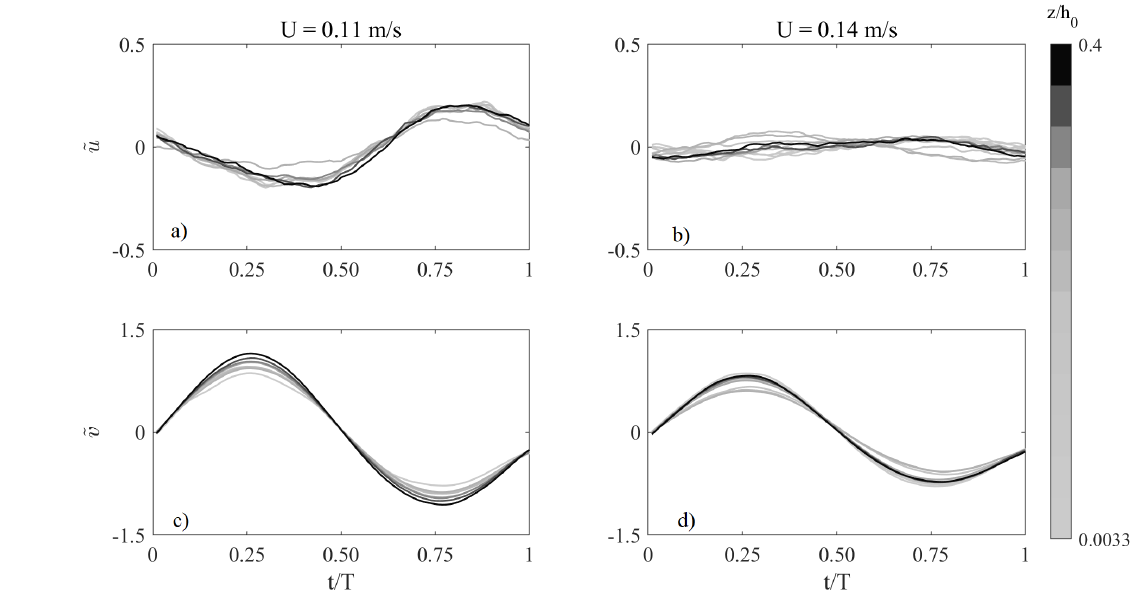
Figure 8. Phase-averaged velocities for tests 9 and 10 (WC, H = 0.085 m, T = 1.0 s) in the crosswise ( a , b ) and streamwise ( c , d ) direction. Both tests have the same local water depth h = 0.26 m but different mean current velocity: U = 0.11 m/s ( a , c ) and U = 0.14 m/s ( b , d